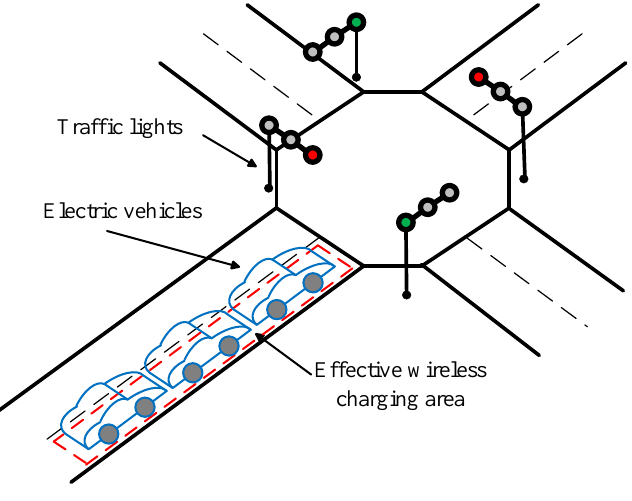
Figure 1. Principle of the opportunity electric vehicle (EV) wireless charging system.